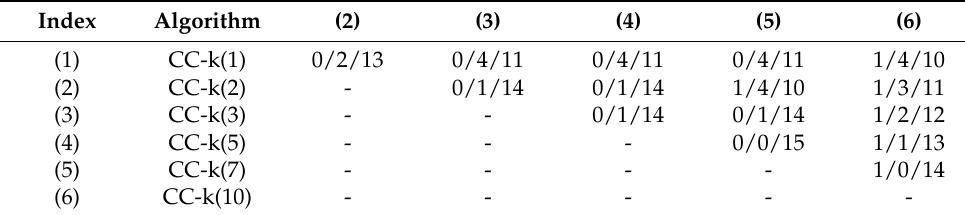
Table 3. The results of the Wilcoxon test for CC-k with different parameter values.